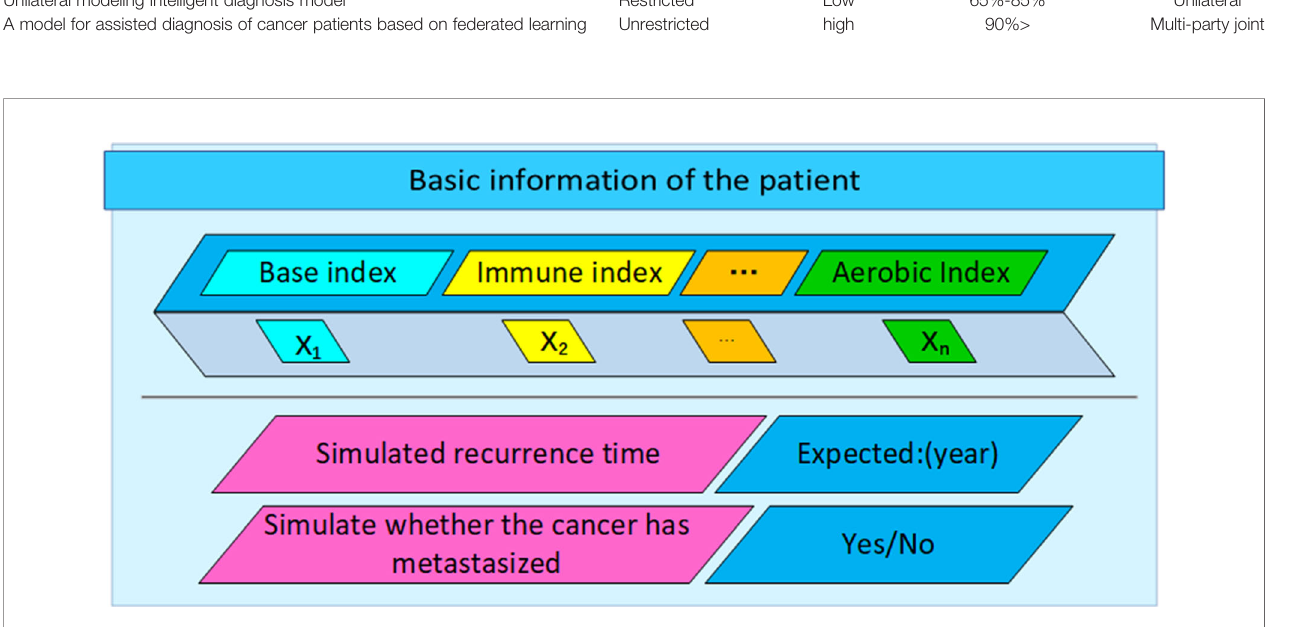
FIGURE 7 | Interactive design of auxiliary diagnosis and treatment